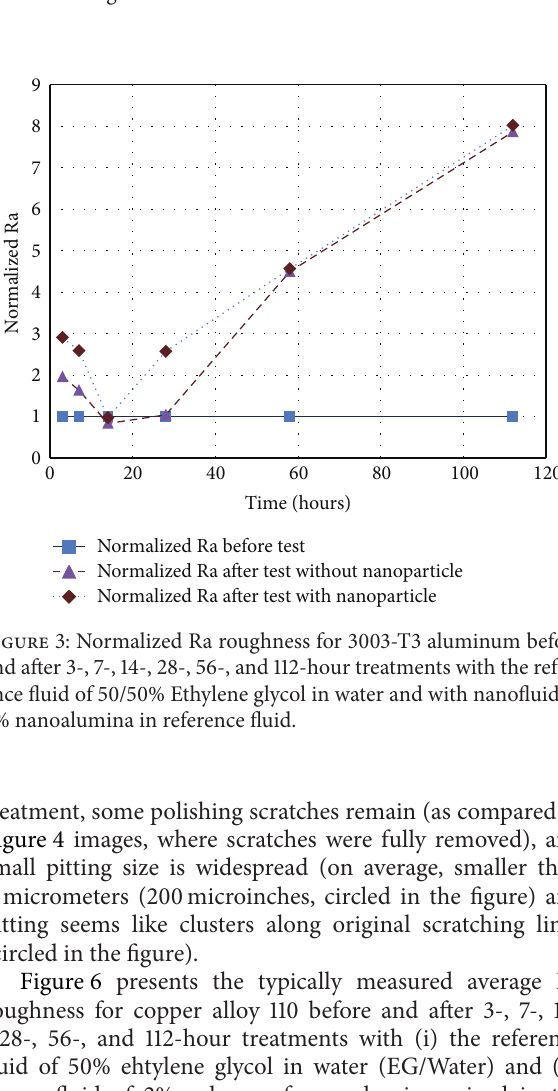
Figure 1: Schematics and photograph of the authors’ test rig to assess nanofluid wear.